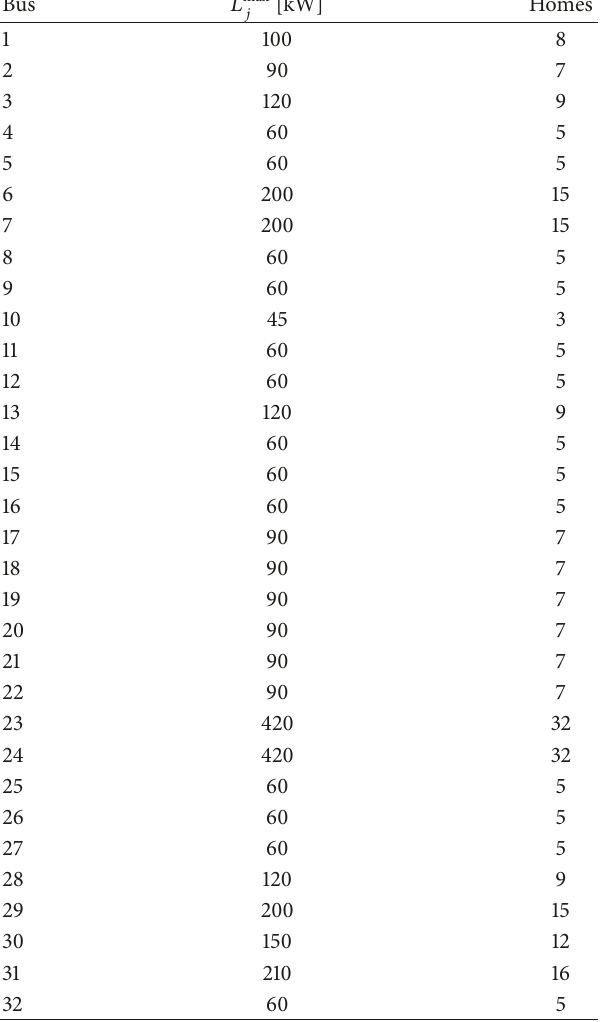
Table 1: Bus maximum scheduled load from [1] and number of homes assuming that each home demands approximately 13kW as in